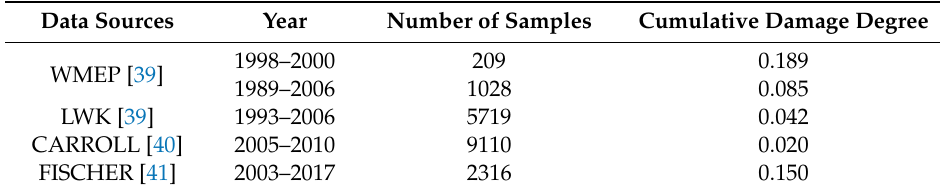
Table 6. Historical statistics of IGBT cumulative damage.